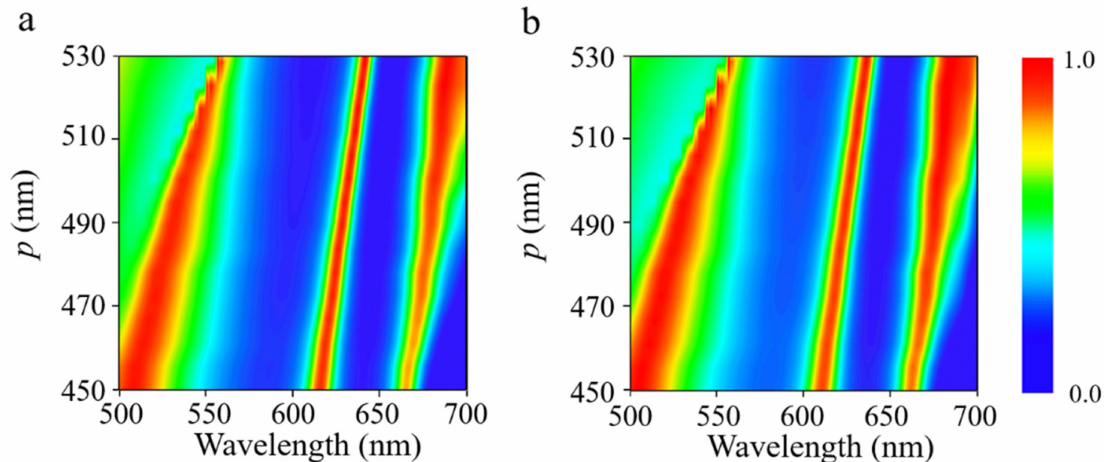
Figure 6. Absorption contour of the proposed structure as a function of wavelength and periodicity p of the proposed structure for incident polarization along ( a ) [100] and ( b ) [001] crystalline directions of α -MoO 3